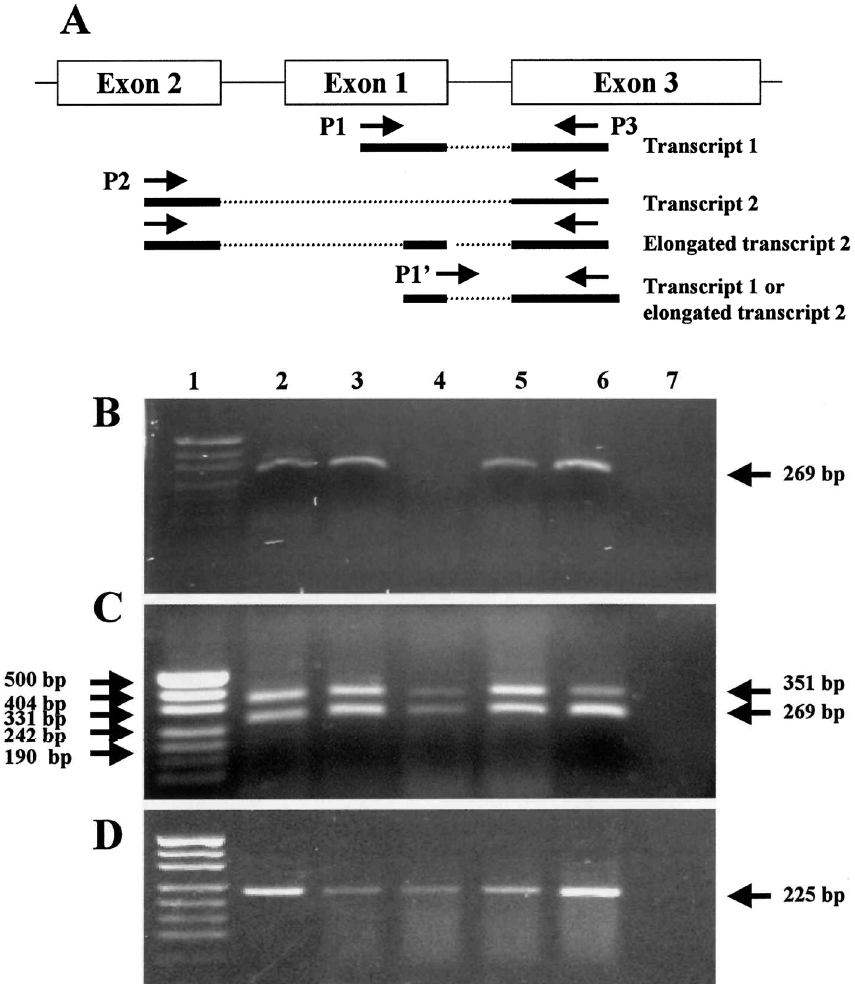
FIG. 1. Expression of PAF-R transcripts in human cancer cell lines derived from the breast (SKBR3, BT20 and T47D cells), the pancreas (Miapaca cells) and the bladder (5637 cells). (A) Schematic representation of the PCR analysis of PAF-R expression. (B) Expression of PAF-R transcript 1 (P1 and P3). (C) Expression of PAF-R transcript 2 and of its elongated form (P2 and P3). (D) Expression of PAF-R transcript 1 and/or of the elongated splice variant of PAF-R transcript 2 (P1 9 and P3). Lane 1, DNA size ladder; lanes 2–6, BT20, T47D, SKBR3, Miapaca and 5637 cells, respectively; lane 7, PCR